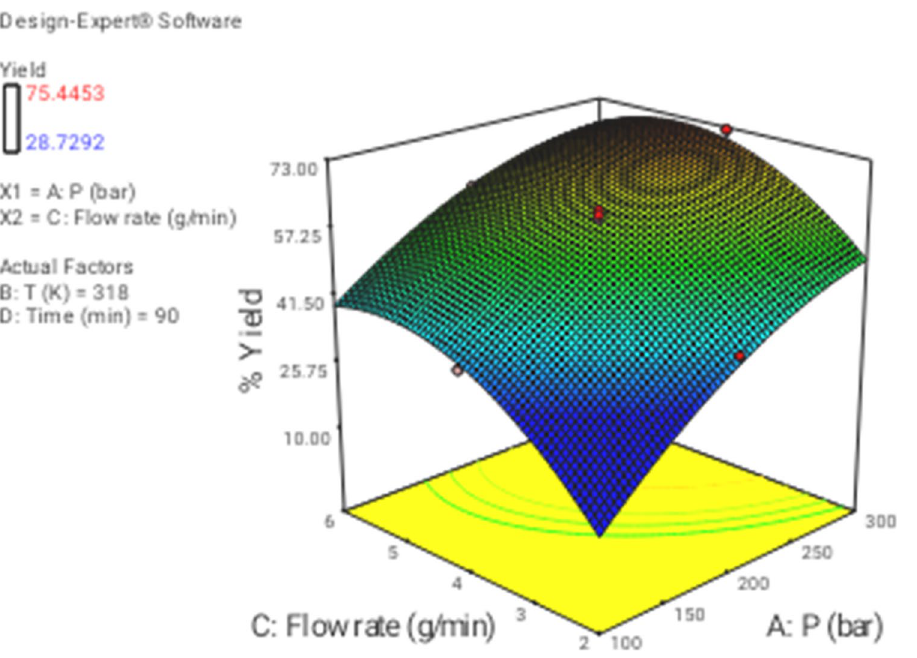
Figure 5. 3D graphic surface for the effects of flow and pressure on the